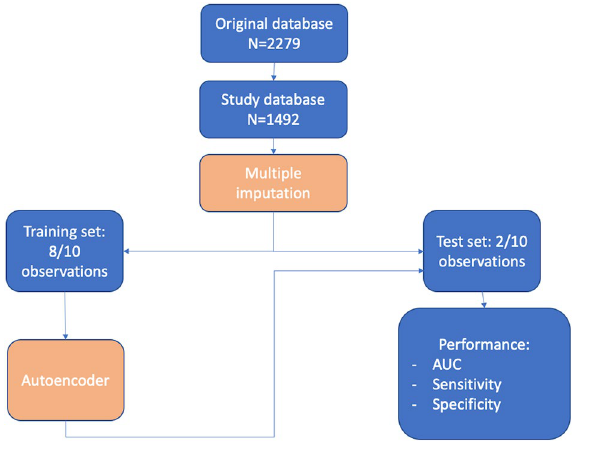
Figure 2. Study flow